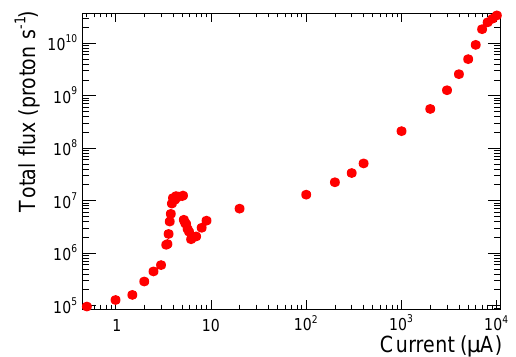
Figure 7. Total cyclotron flux as a function of the ion source arc current. Figure taken from